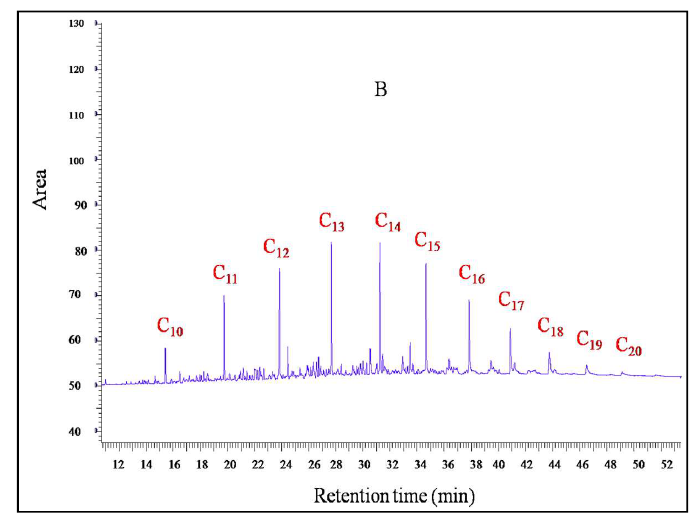
Figure 1. A conventional Gas Chromatography (GC) analysis of pure fuel ( A ) and crude oil polluted soil ( B ).